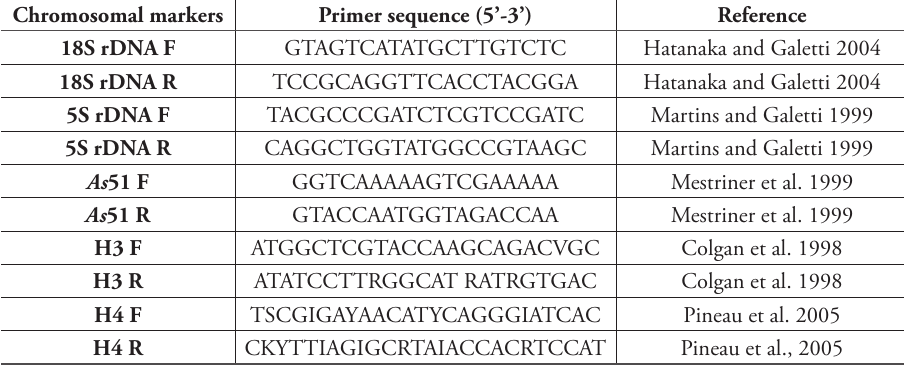
Table 1. Primer sequences